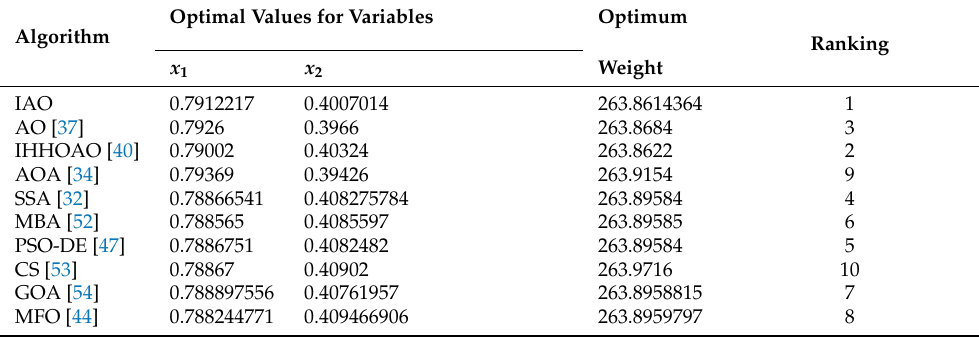
Figure 9. Three-bar truss design problem. Table 16. Results of the compared algorithms for solving three-bar truss design